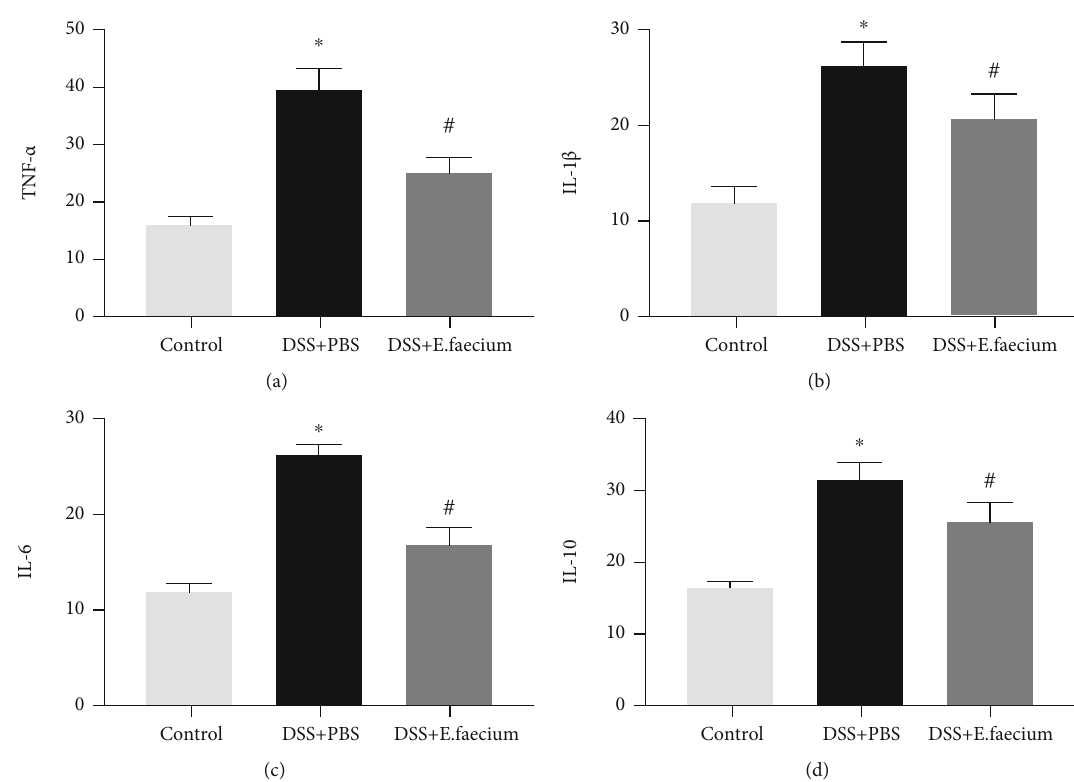
Figure 4: E. faecium treatment alleviates gut in fl ammation. In fl ammatory cytokines: (a) TNF- α , (b) IL-1 β , (c) IL-6, and (d) IL-10. ∗ P < 0 : 05 vs. control group; # P < 0 : 05 vs. DSS +PBS group.